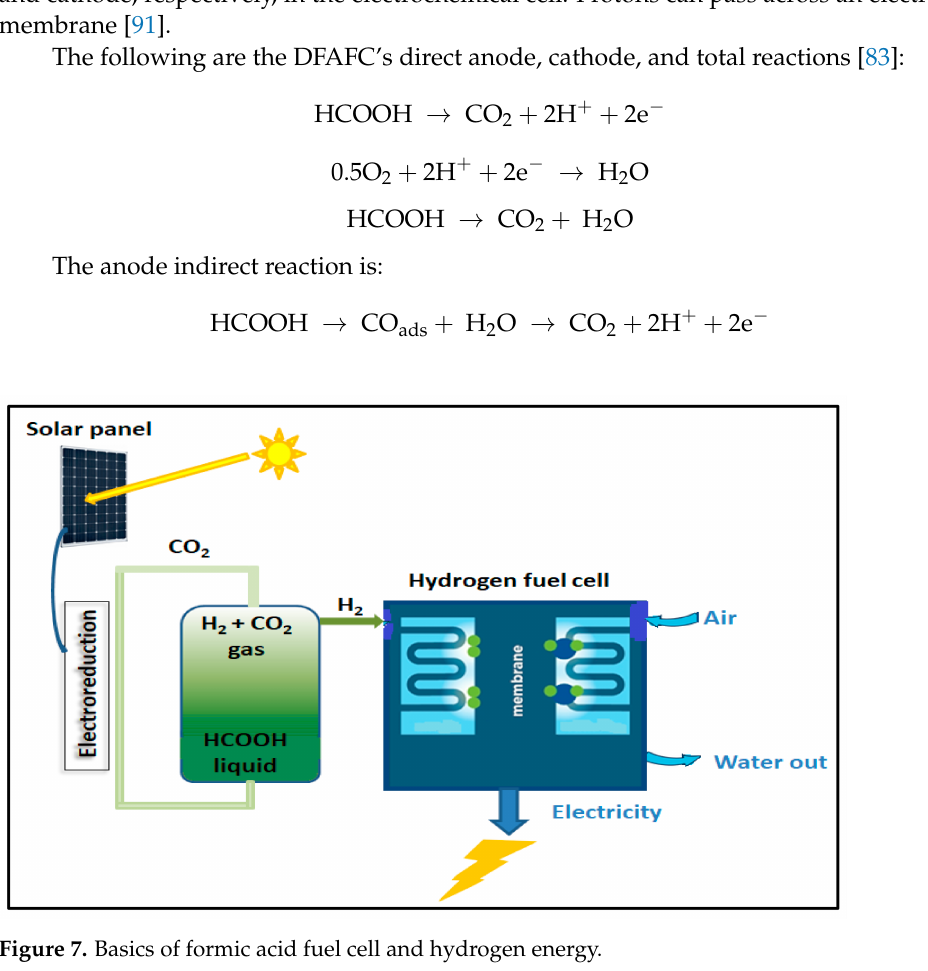
Figure 7. Basics of formic acid fuel cell and hydrogen energy. Direct FA oxidation occurs at the anode through decomposition (Equation (3)) [85]. In the optimal direct pathway, HCOOH → ∗ HCOO ( formate ) or ∗ COOH ( carboxyl ) converts fully into H and CO 2 2